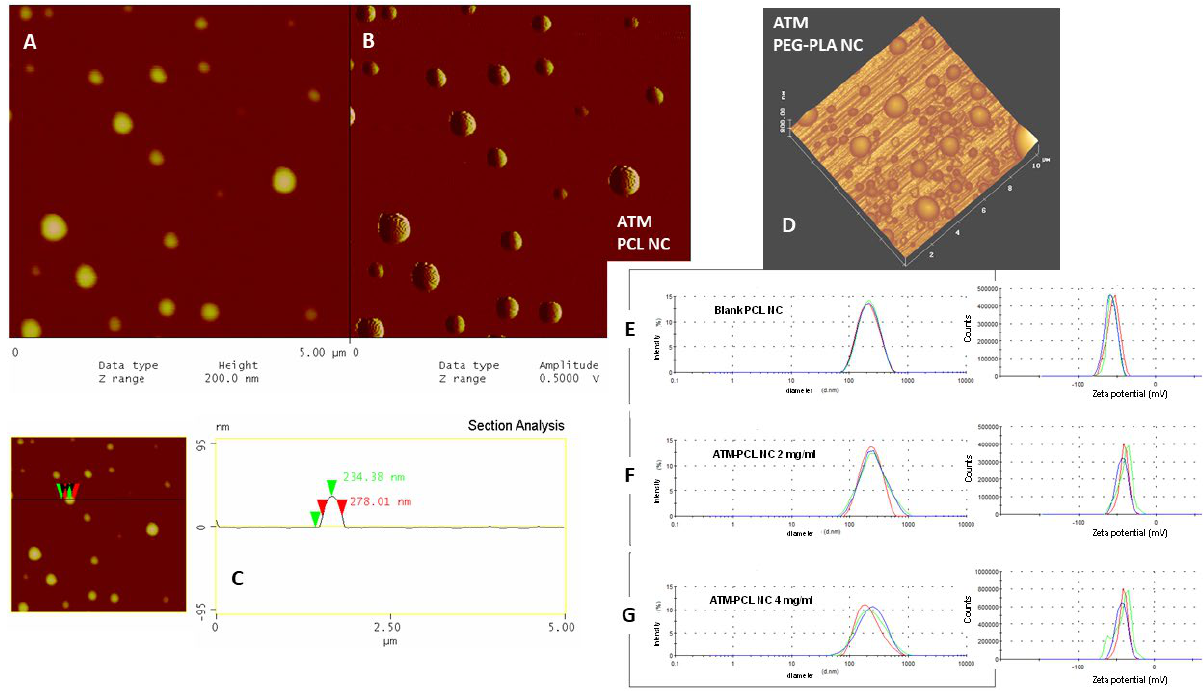
Figure 2. Morphological characterization of nanocapsules by atomic force microscopy (AFM) in ( A – D ) images, zeta potential, and size distribution by intensity determined by dynamic light scattering (DLS) in ( E – G ) graphs. ( A ) is the AFM height and ( B ) is the corresponding AFM phase images of ATM-PCL-NC 2 mg/mL and ( D ) is the 3D AFM image of ATM-PEG-PLA NC 2 mg/mL showing the size dispersion of spherical particles deposited under mica plates. Scheme ( C ) is the topographical profile of a selected NC in image ( A ) showing the measurement of diameter at half-height and the values measured by the equipment. In ( E ): blank-PCL-NC; ( F ): ATM-PCL-NC 2 mg/mL and ( G ): ATM-PCL-NC 4 mg/mL formulations.